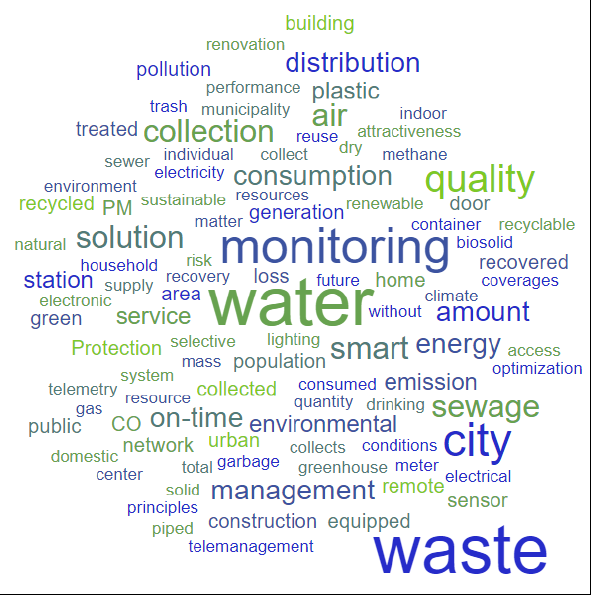
Figure 15. Most frequent indicators within the theme of